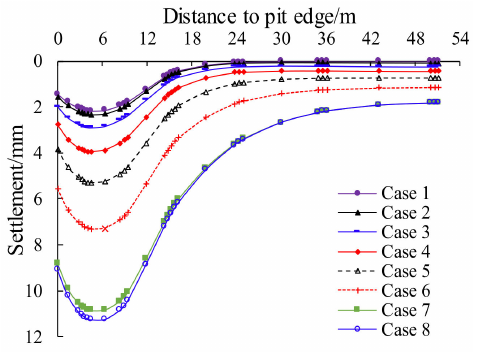
Figure 20. Ground